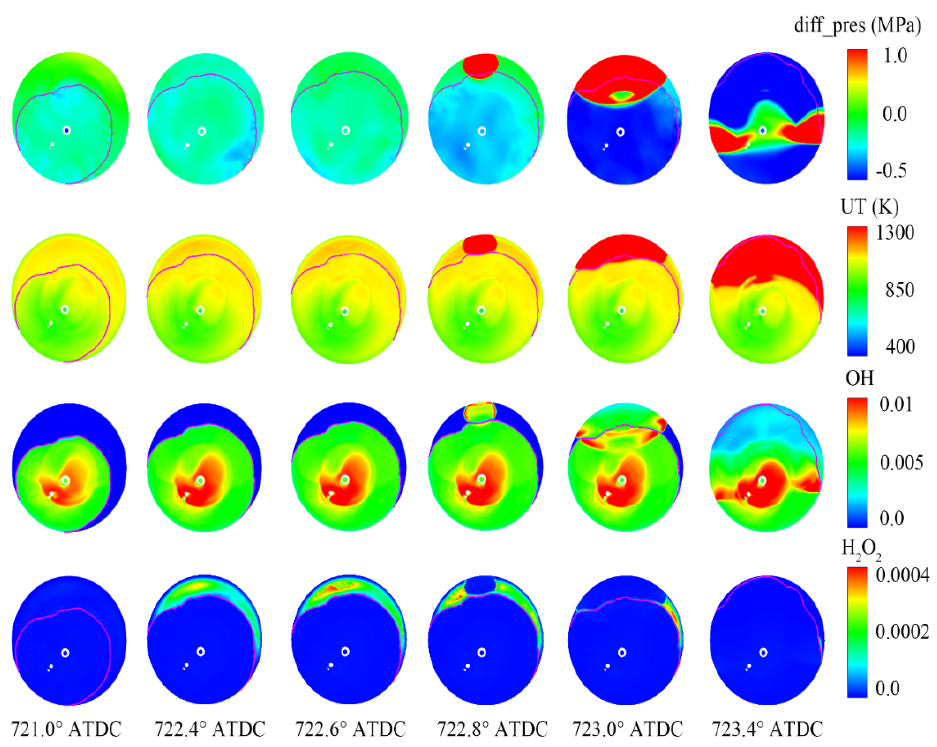
Figure 12. Flame and pressure wave propagation process during knock [48].